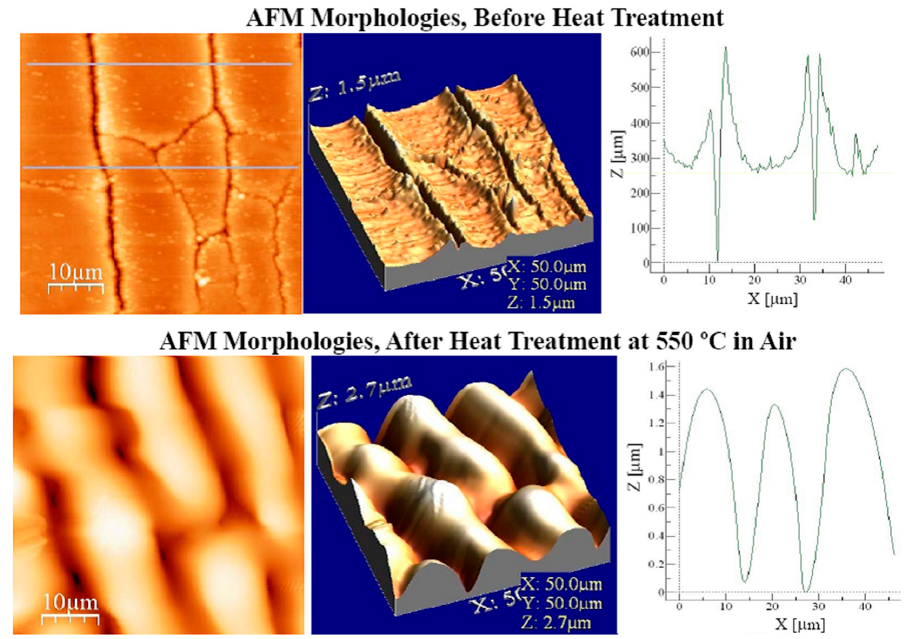
Figure 12. Tapping-mode atomic force microscope (AFM) height, three-dimensional (3D), and cross-section images and data for thin films of ionic polymer P-1 before and after heat treatment at 550 °C in air for 30 min.